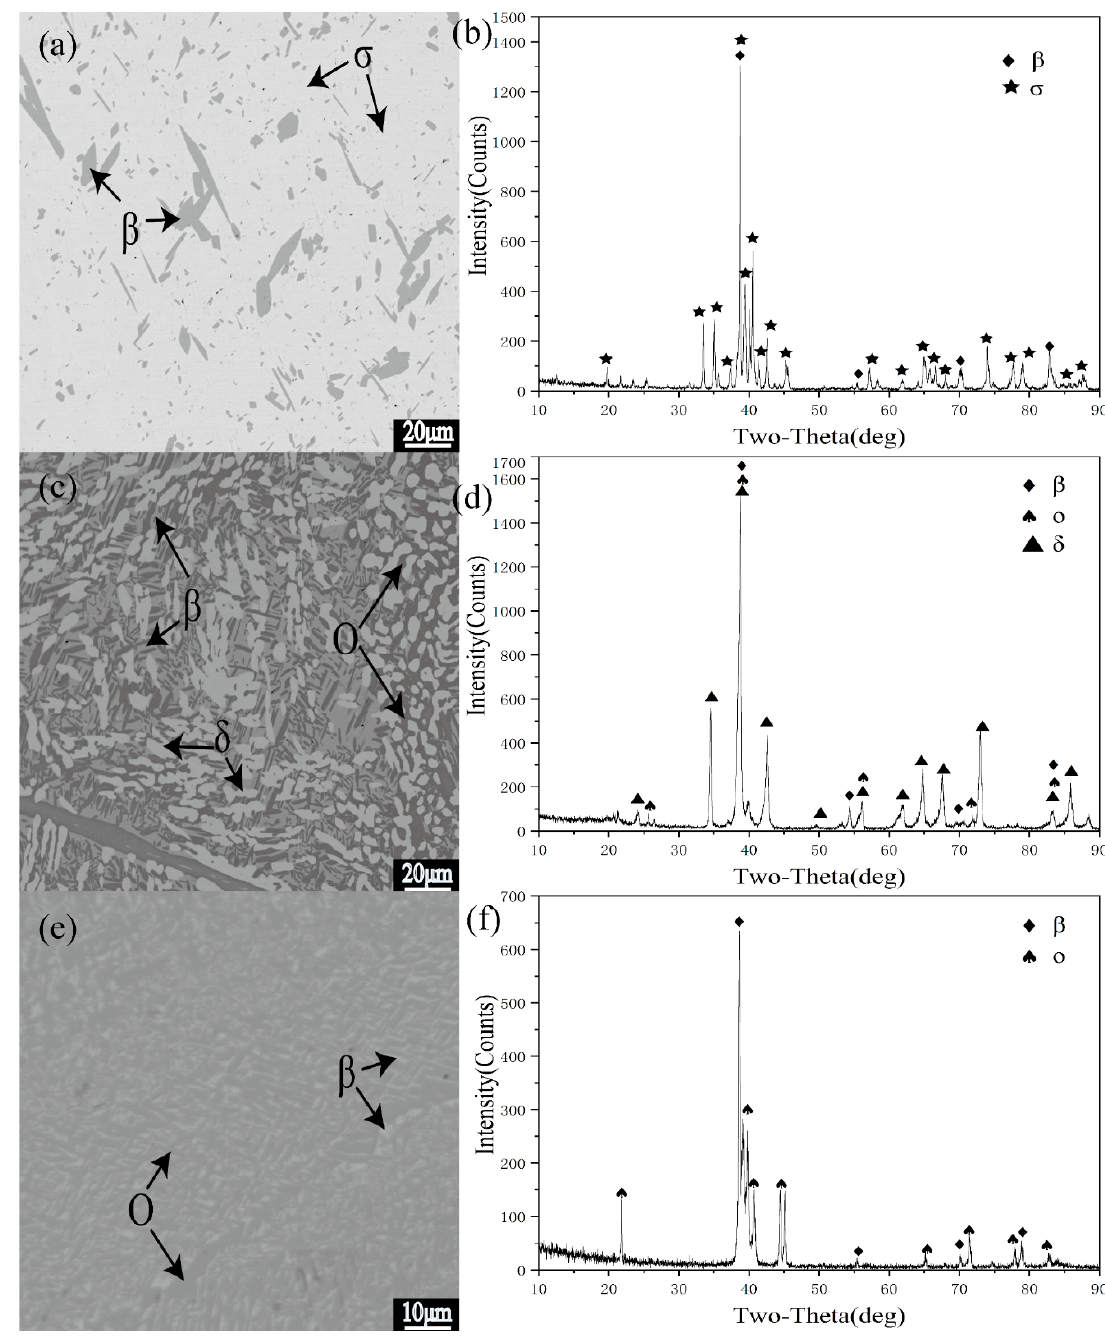
Figure 5. EPMA images and XRD results of alloy #7 after annealing at 1000 °C, 900 °C, 800 °C. ( a ) The microstructure of alloy #7 at 1000 °C; ( b ) the XRD result of alloy #7 at 1000 °C. ( c ) The microstructure of alloy #7 at 900 °C; ( d ) the XRD result of alloy #7 at 900 °C. ( e ) The microstructure of alloy #7 at 800 °C; ( f ) the XRD result of alloy #7 at 800 °C.